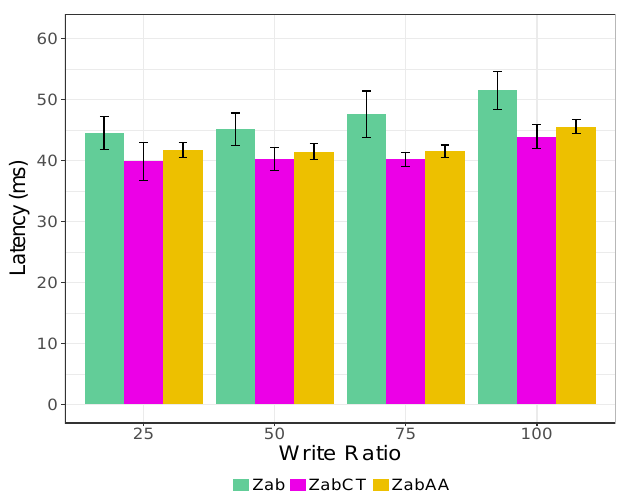
Figur e 4. Latency comparison for Zab, ZabCT and ZabAA for N=3.